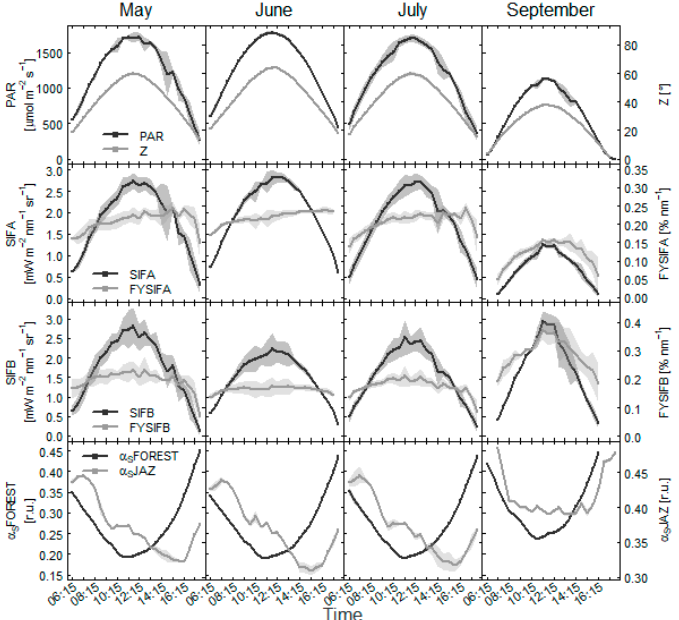
Figure 8. Diurnal change of incoming PAR to the forest at the Štítná site on days evaluated as clear days. Daily dynamics of fluorescence emission in O 2 A band and O 2 B bands are shown with adjacent change in the yield of this emission. Dynamics of shadow fraction in area under spectrometer ( α S JAZ) and at the forest level ( α S FOREST) at corresponding sun azimuth and zenith angles (Z) are shown in the bottom panel.